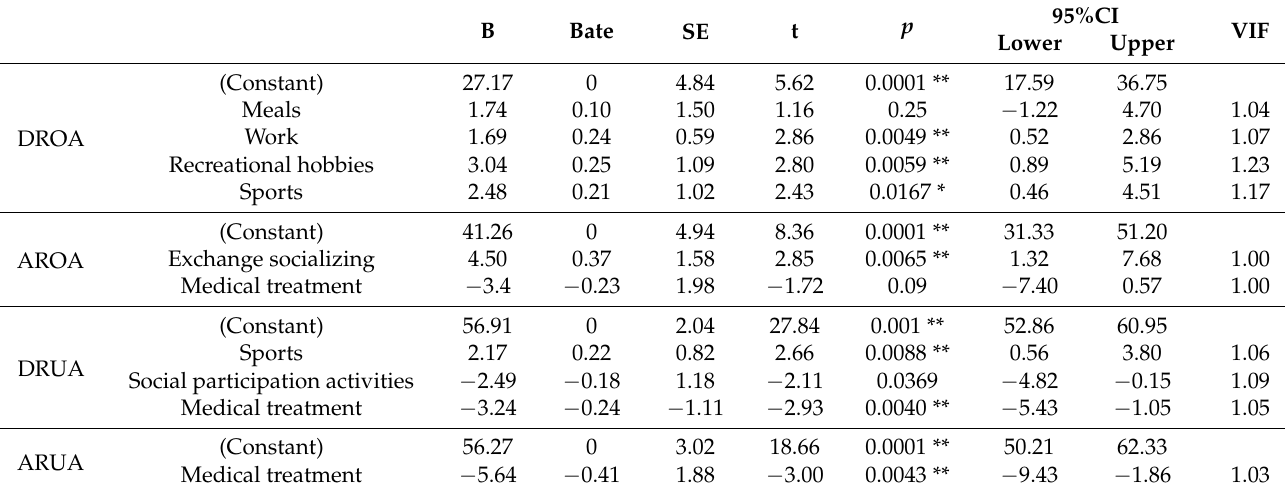
Table 3. Logistic regression results of the PCS.